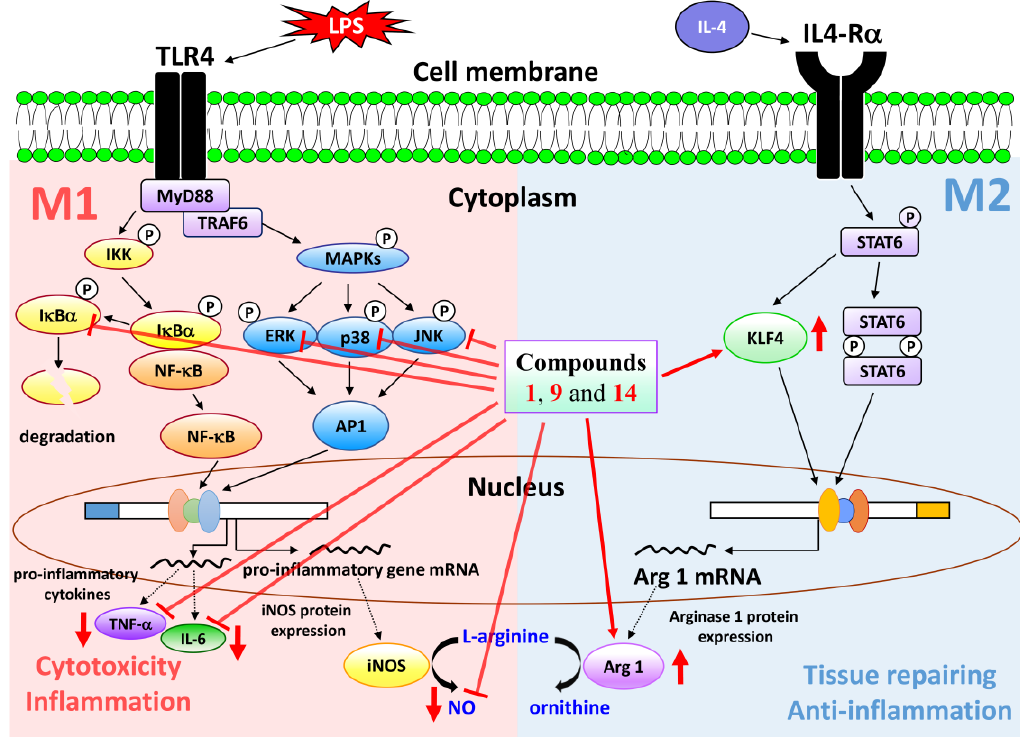
Figure 8. Schematic diagram for anti-inflammatory action of compounds 1 , 9 , and 14 in LPS-induced RAW264.7 macrophages.